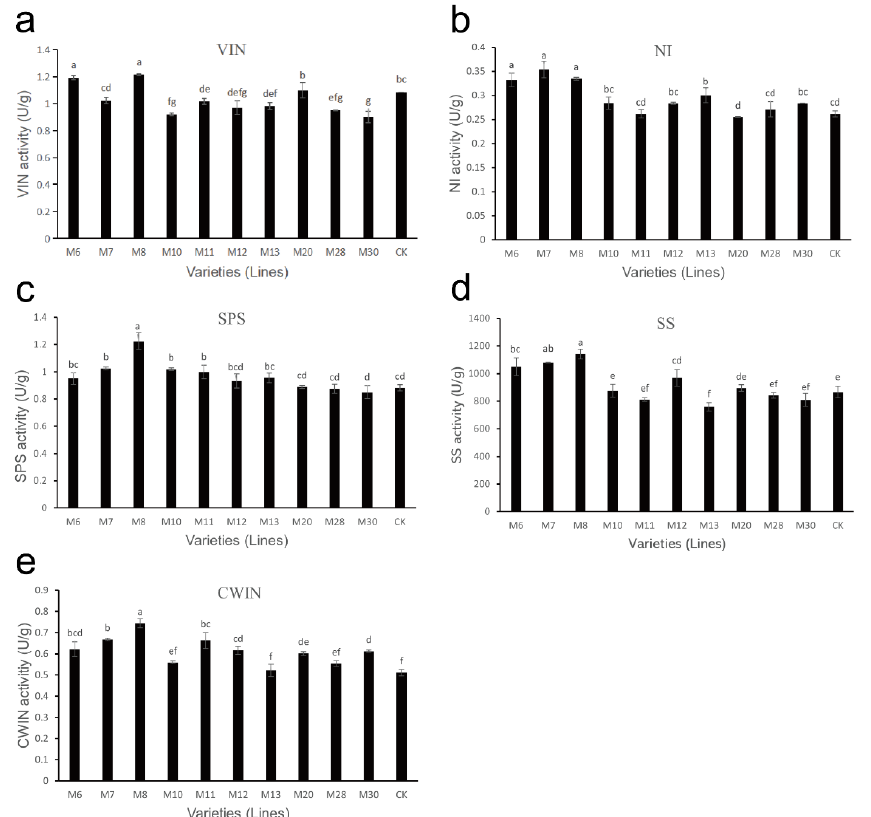
Figure 5. Changes in sucrose metabolism-related enzyme activities in wild A. eriantha of different varieties (lines) at the ripening stage, including VIN ( a ), NI ( b ), SPS ( c ), SS ( d ) and CWIN ( e ). The different letters in each figure indicate significant differences ( p < 0.05), and the same letters indicate no significant difference ( p > 0.05).